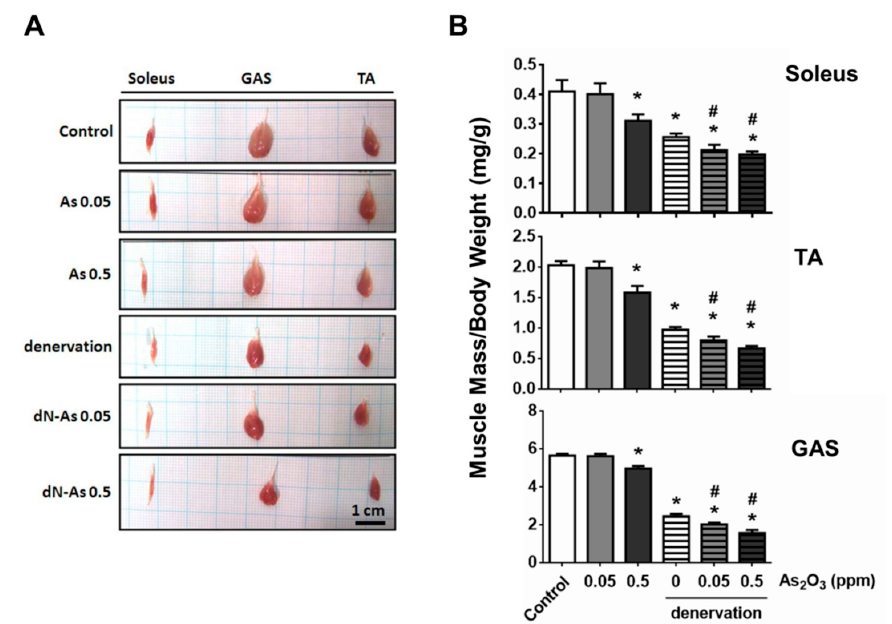
Figure 2. E ff ects of As 2 O 3 on the muscle mass in mice with or without denervation. As 2 O 3 (0.05 and 0.5 ppm) exposure from drinking water for 4 weeks in normal mice or denervated mice. ( A ). The gross morphology of each group in soleus, tibialis anterior (TA), and gastrocnemius (GAS) muscles were shown. Scale bar = 1 cm. ( B ). The average muscle mass of soleus, tibialis anterior, and gastrocnemius muscles were shown. Data are presented as the mean ± SEM ( n = 6 of each group). * P < 0.05 compared to control group; # P < 0.05 compared to denervation group.